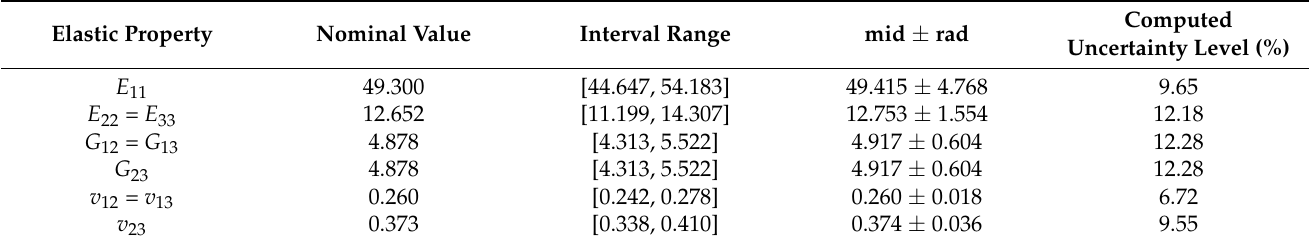
Table 6. Nominal values and computed uncertainty intervals of the elastic properties of the 21xK43- LY556 composite ply.